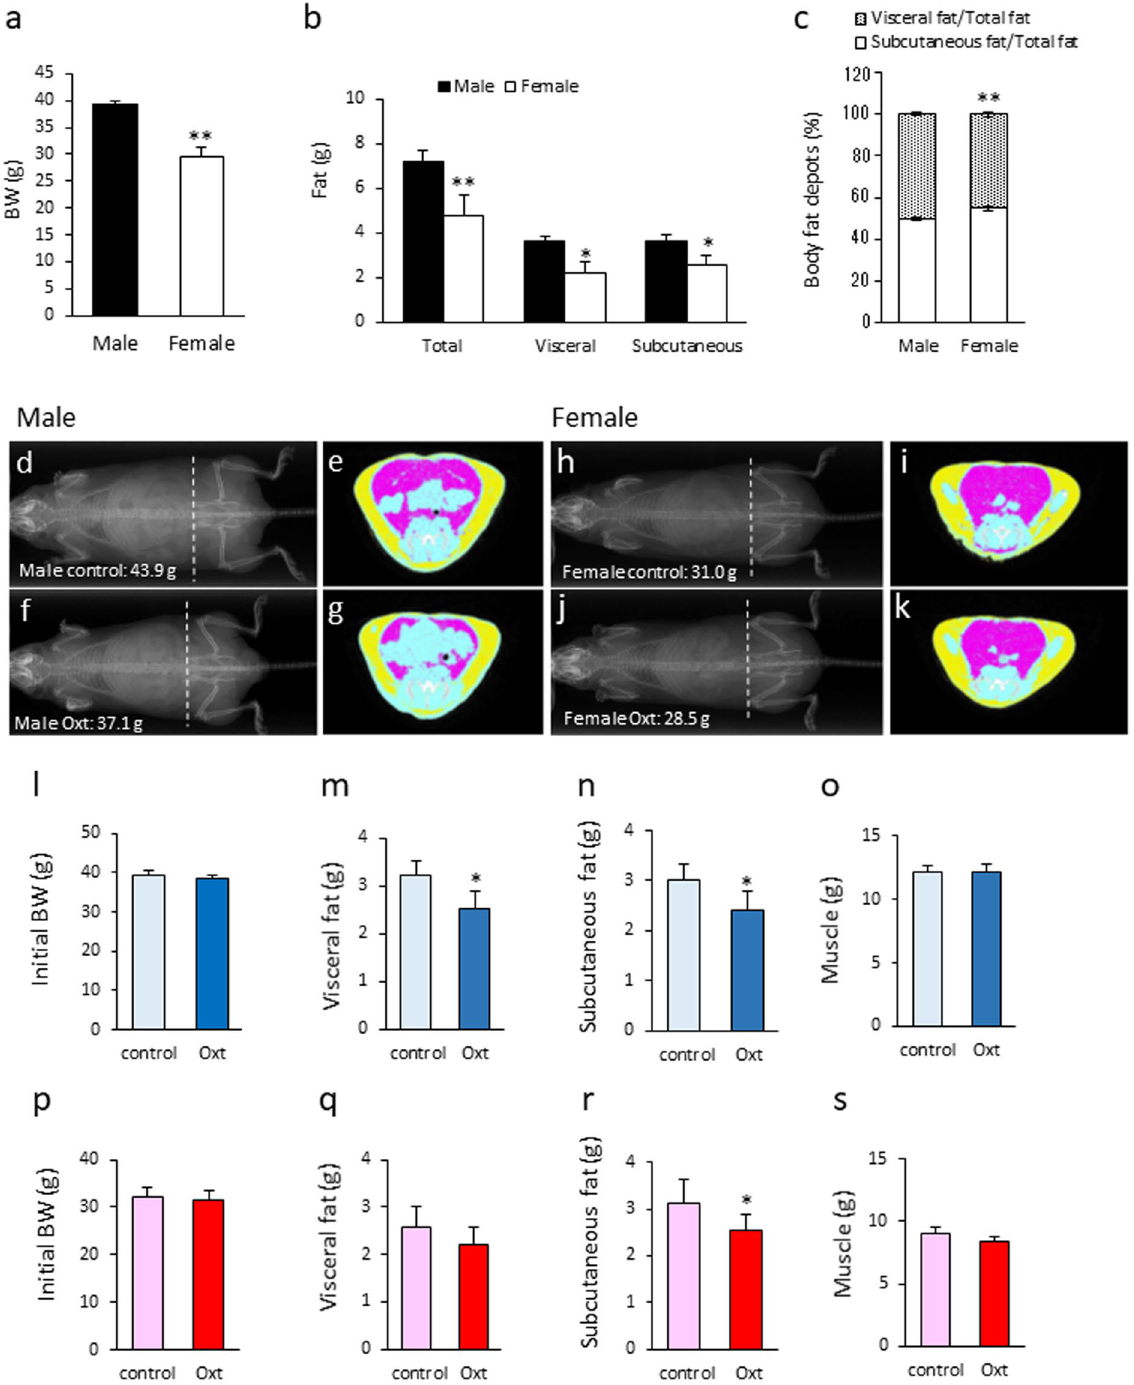
Figure 2. The effect of Oxt treatment on visceral fat and subcutaneous fat in male and female mice fed a high- fat diet. ( a ) Body weight of 8-week-old HFD-fed males and 12-week-old HFD-fed females. (n = 11, 9) ( b ) Weight of total fat, visceral fat, and subcutaneous fat analysed by CT scan in HFD-fed male and female mice. (n = 11, 9) ( c ) Ratio of the visceral fat to the total fat, and ratio of the subcutaneous fat to the total fat in HFD- fed male and female mice. (male n = 11, female n = 9). * P < 0.05, ** P < 0.01 by unpaired Student’s t -test. ( d–g ) Representative X-ray ( d,f ) and CT image ( e,g ) of HFD-fed control ( d,e ) and Oxt-treated ( f,g ) mice. CT images of e and g are sectional images of the white dotted lines (level of vertebra L6) in ( d and f ), respectively. Yellow areas indicate subcutaneous fat and pink areas indicate visceral fat. The BW of mice scanned by CT was 43.9 g and 37.1 g in control and Oxt-treated mice, respectively. CT scanning was performed at 10 days after starting Oxt infusion. ( h–k ) Representative X-ray ( h,j ) and CT image ( i,k ) of HFD-fed control ( h,i ) and Oxt-treated ( j,k ) female mice. CT images of i and k are sectional images of the white dotted lines (level of vertebra L6) in ( h and j ), respectively. Yellow areas indicate subcutaneous fat and pink areas indicate visceral fat. The BW